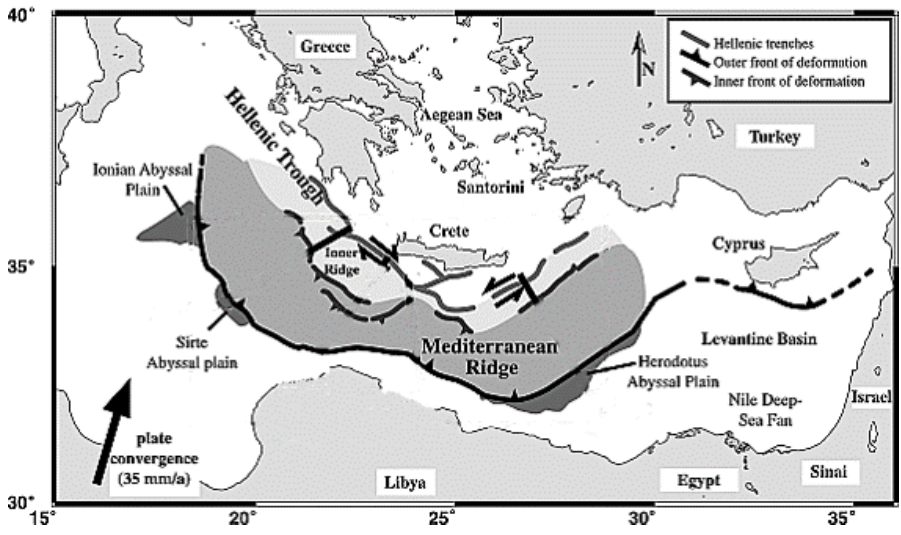
Figure 1. Location of the Mediterranean Ridge accretionary complex (MAC) in the Eastern Mediterranean Sea basin. The arrows indicate the present plate kinematic direction and rate between Africa and Eurasia [18,19].